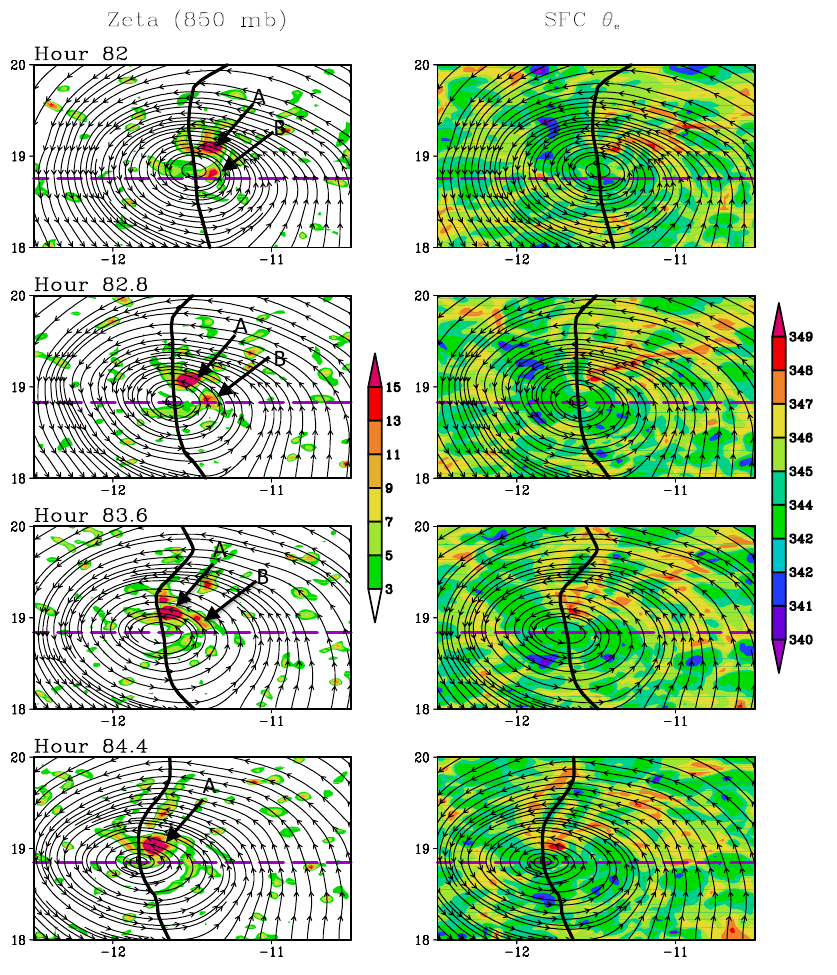
Fig. 13. Evolution of VHTs from Hour 82 to Hour 84.4 (3kmmesh). The left panels are 850hPa relative vorticity (unit: 10 − 4 s − 1 ), the right panels are the surface θ e (K), and both are superimposed on the 850hPa translated streamlines. The black curve is the wave trough axis, and the purple line represents the wave critical latitude. The two vortices discussed in the text are indicated by black arrows and letters (A and B) in the left panels. The ordinate is latitude and the abscissa is longitude.